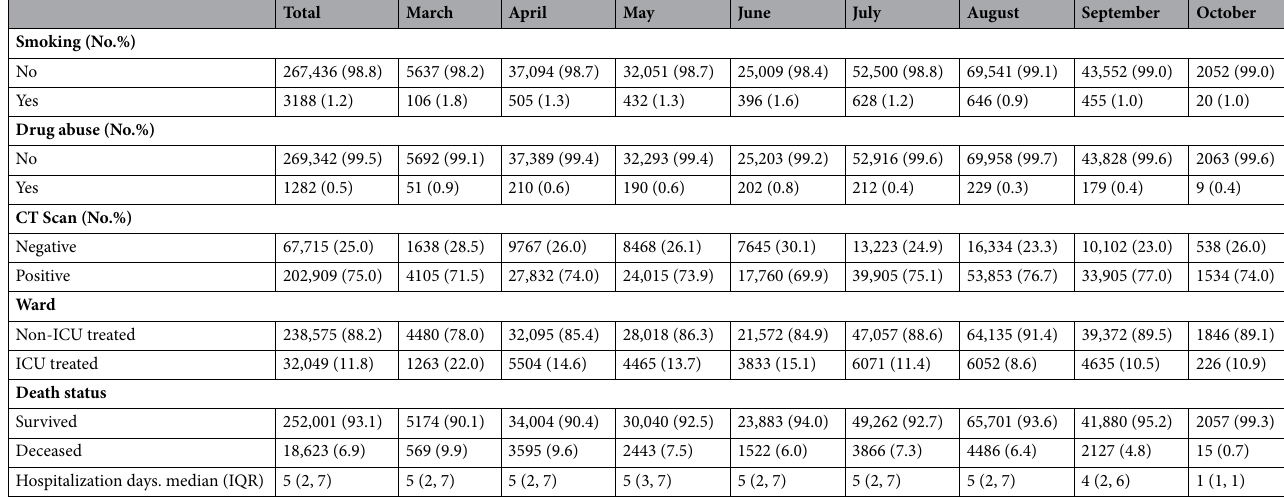
Table 1. Characteristics of patients at baseline, stratified by month of admission. Abbreviation : Intensive care unit (ICU), HIV (human immunodeficiency